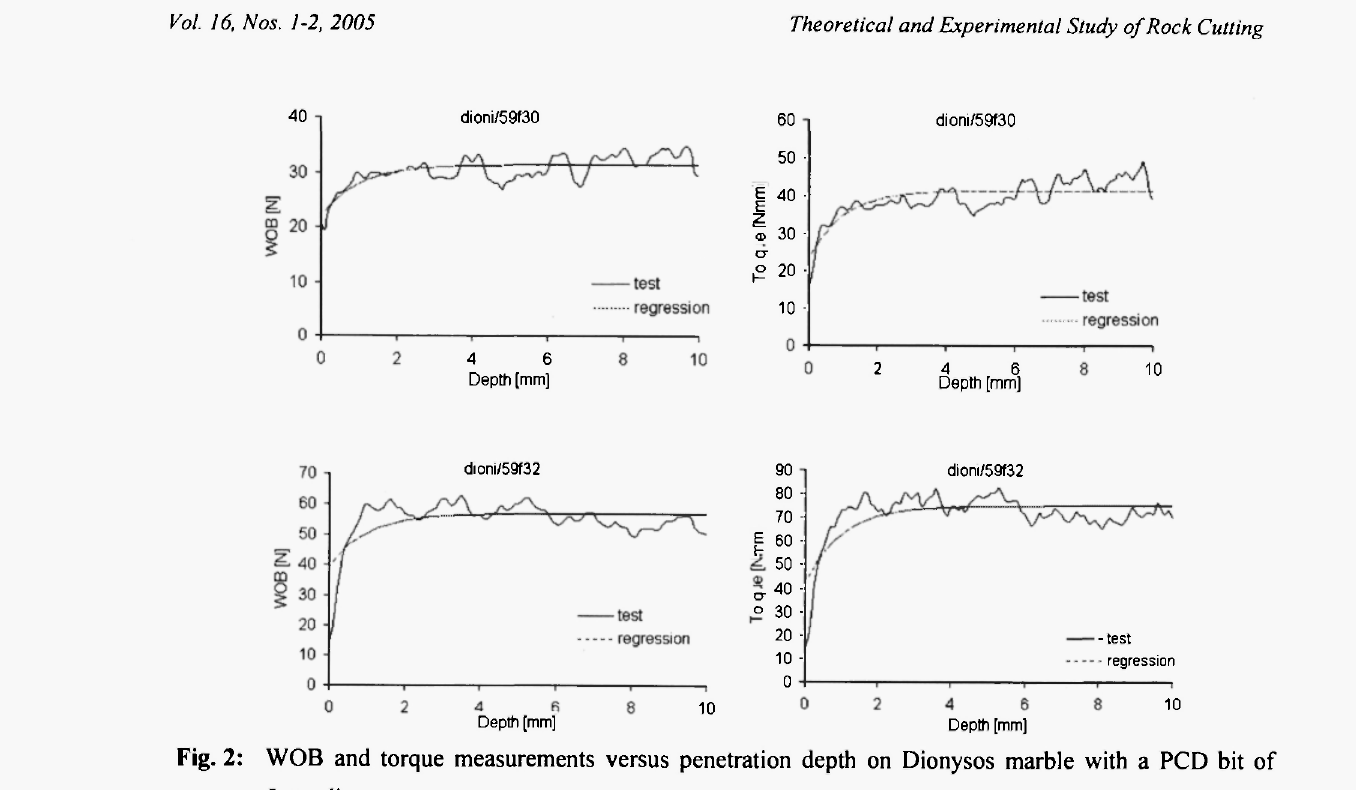
Operational parameters and test results of the drilling